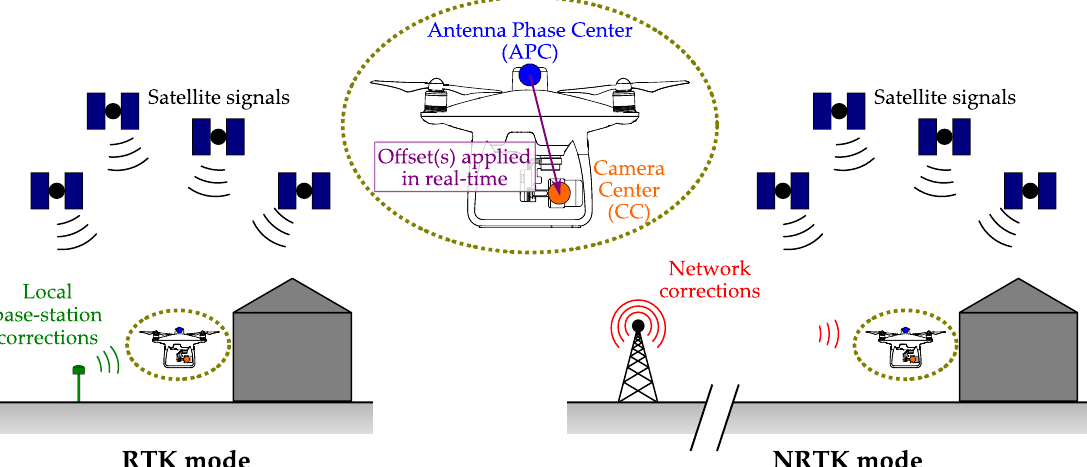
Figure 2. Scheme of image dataset acquisition with DJI-P4RTK in RTK and NRTK modes. APC–CC offsets are also applied in real-time.